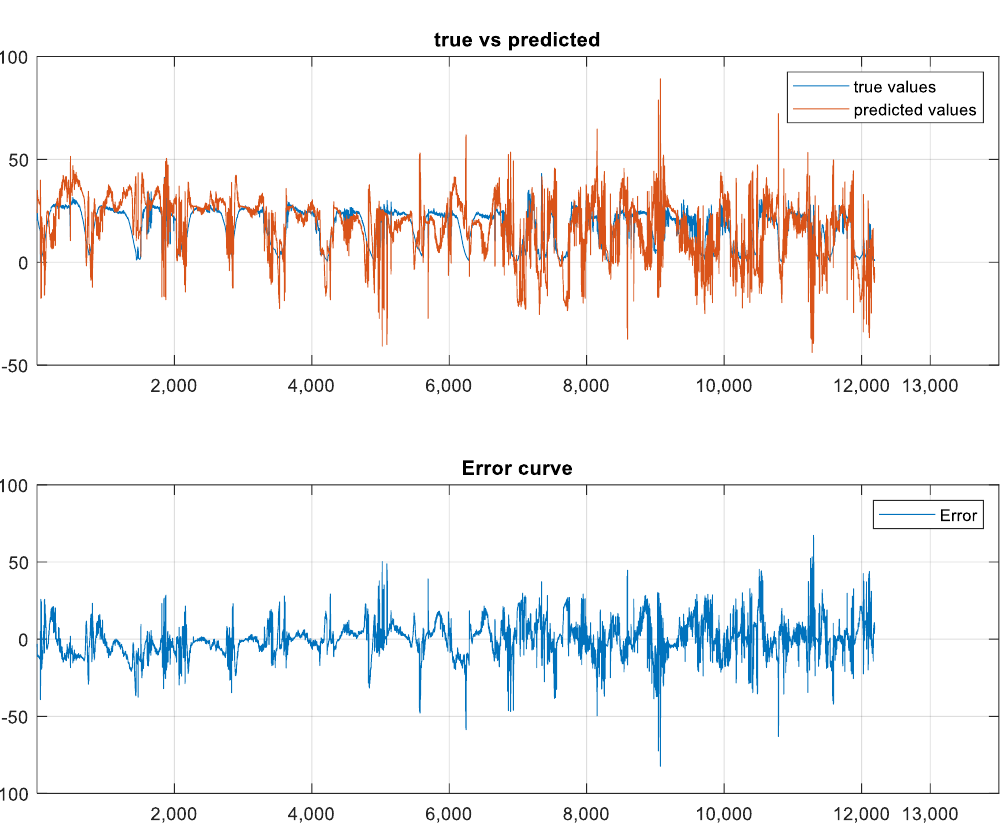
Figure 6. Error and output of GA – ANN results (first test).